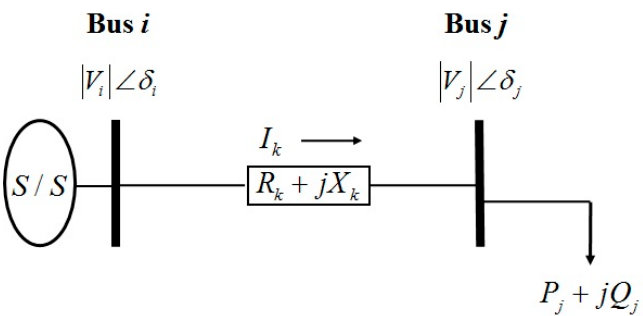
Figure 6. Equivalent circuit of a radical distribution system (RDS).